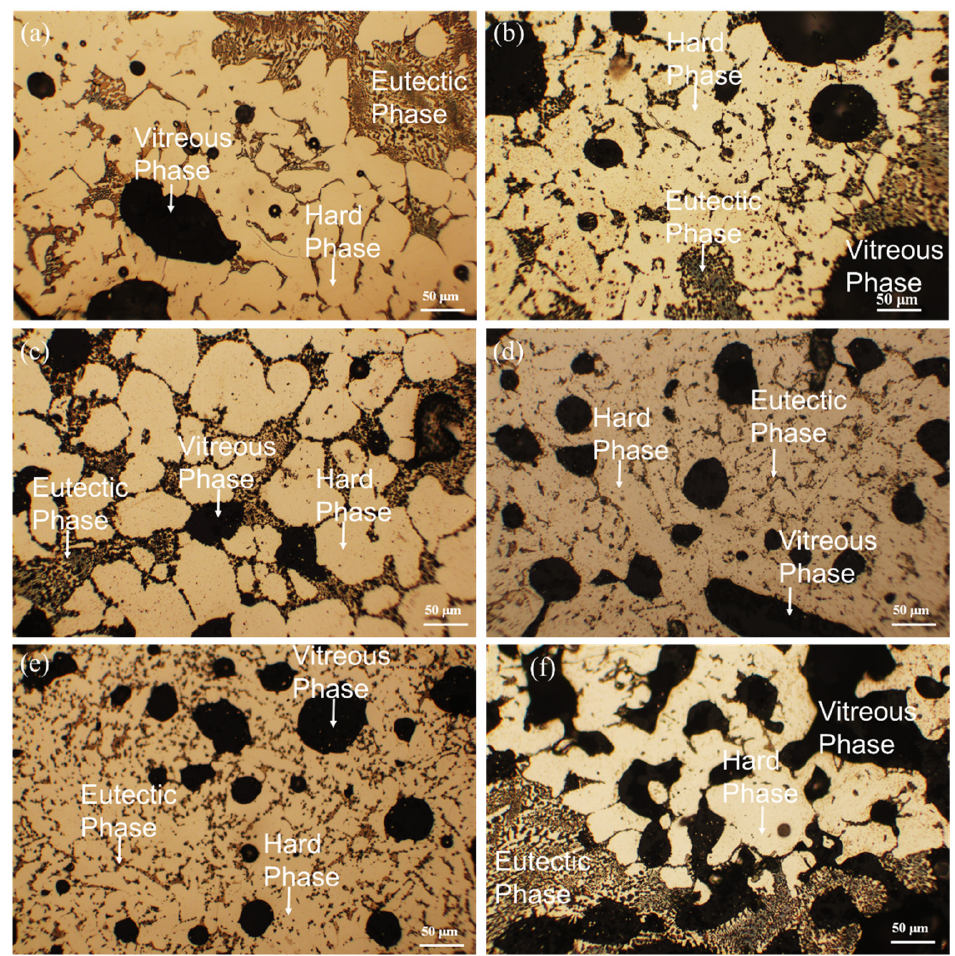
Figure 3. Micrographs of the cross-sectional hardfacing sintering in an oven with different atmospheres: ( a ) 10C, ( b ) 9C, ( c ) 7C, ( d ) 5C, ( e ) 3C and ( f ) 1C. Table 6. Volumetric fractions of the phases presented in six different hardfacing